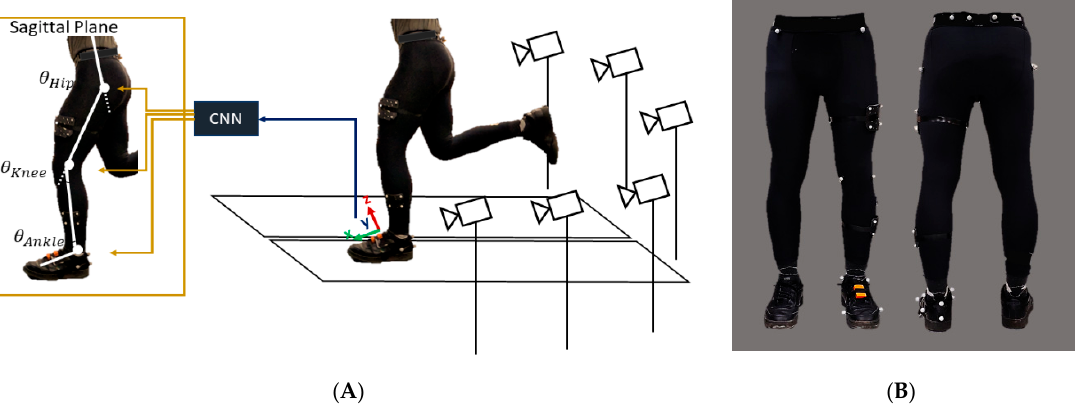
Figure 1. ( A ) Experimental setup including six motion capture cameras and a split-belt treadmill. The schematic of angles estimated using the raw signal of a foot-mounted accelerometer. ( B ) Reflective marker positions on the lower extremity.